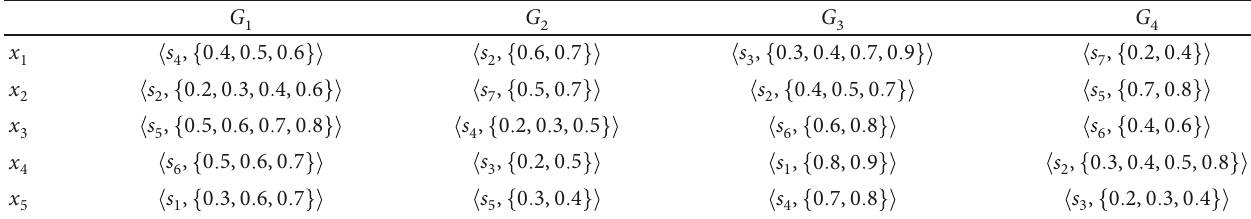
Table 1: Original hesitant fuzzy linguistic decision